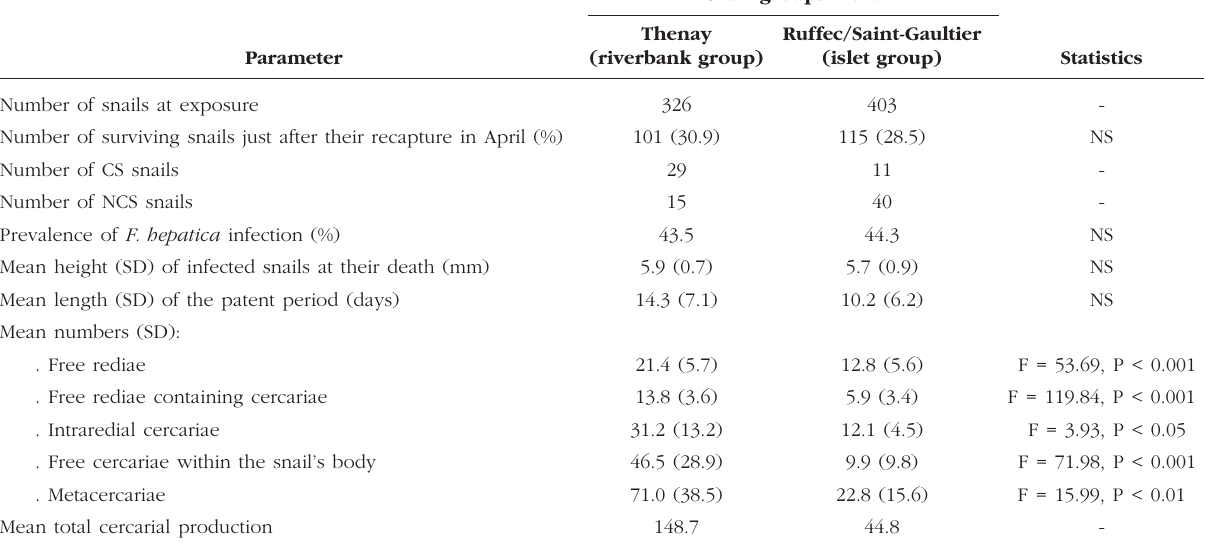
Table II. – Main parameters of F. hepatica infection in riverbank G. truncatula after their collection in April